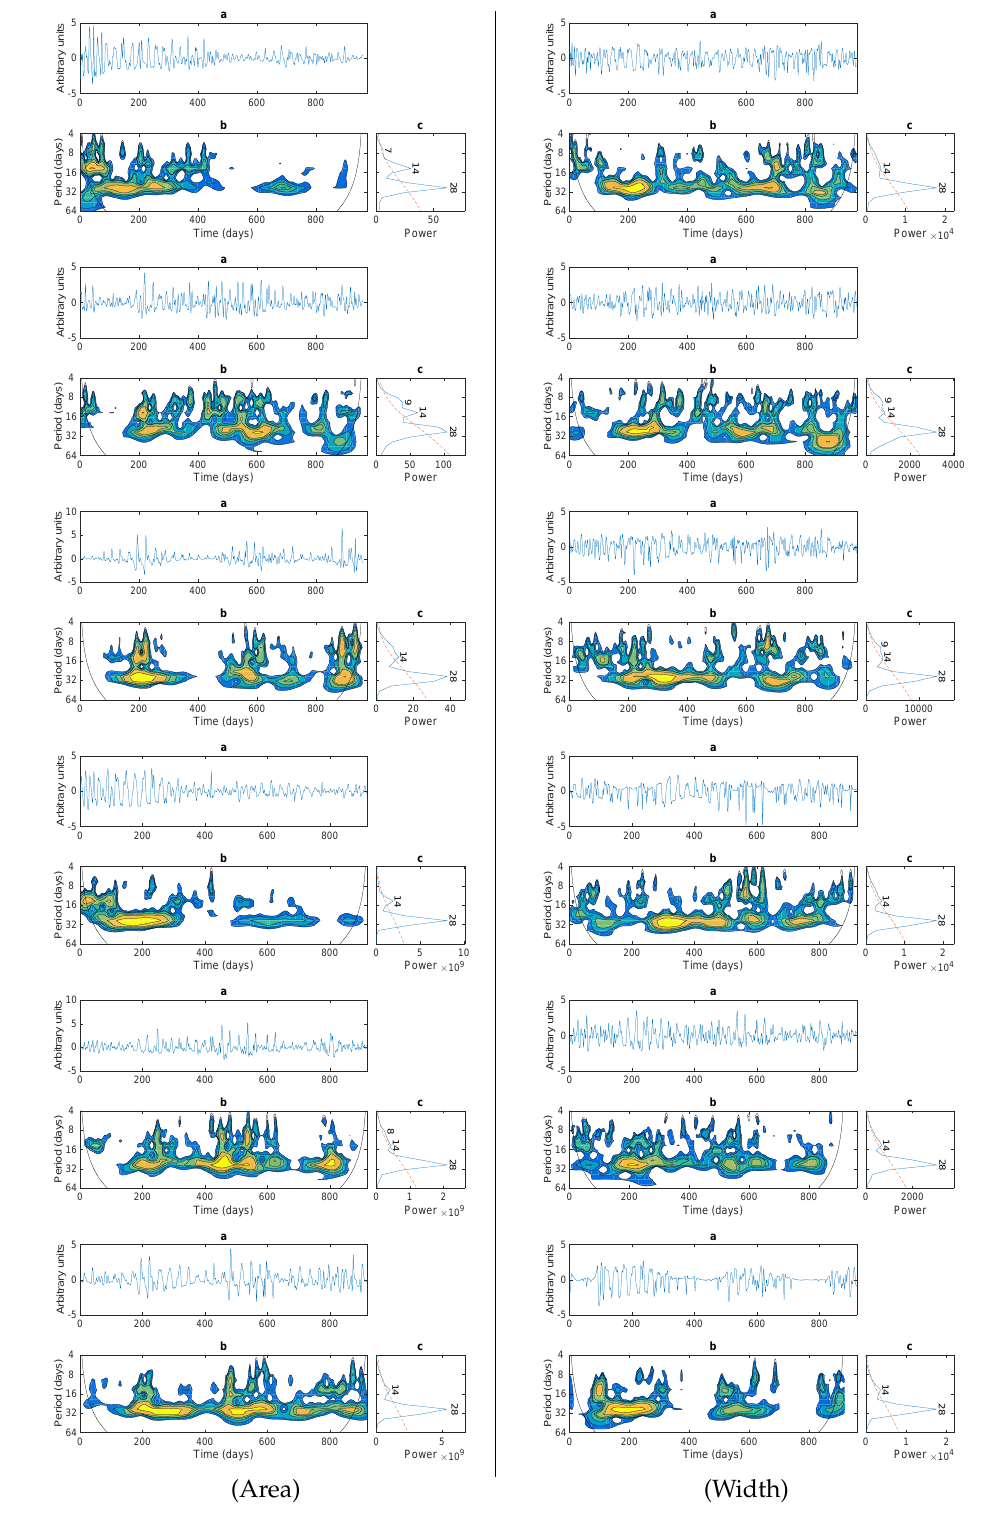
Figure 6. Wavelet spectra of daily maximal areas ( Area ) and longitudinal width ( Width ) variations in CHs. Plots in the figure located in the following order: first from top: CHIMERA north; second from top: CHIMERA equator; third from top: CHIMERA south; fourth from top: RGA north; fifth from top RGA equator; sixth from top RGA